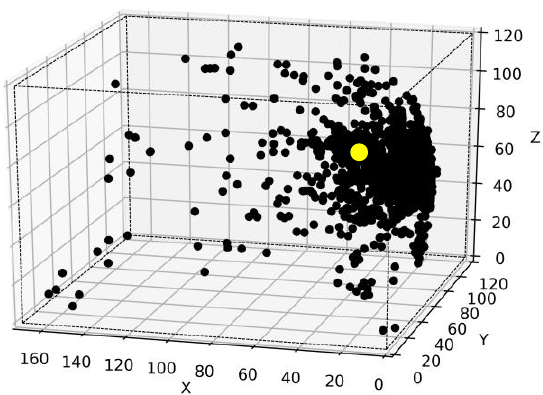
Figure 9. Distribution of pseudo-targets. The number of pseudo-targets is 2145.